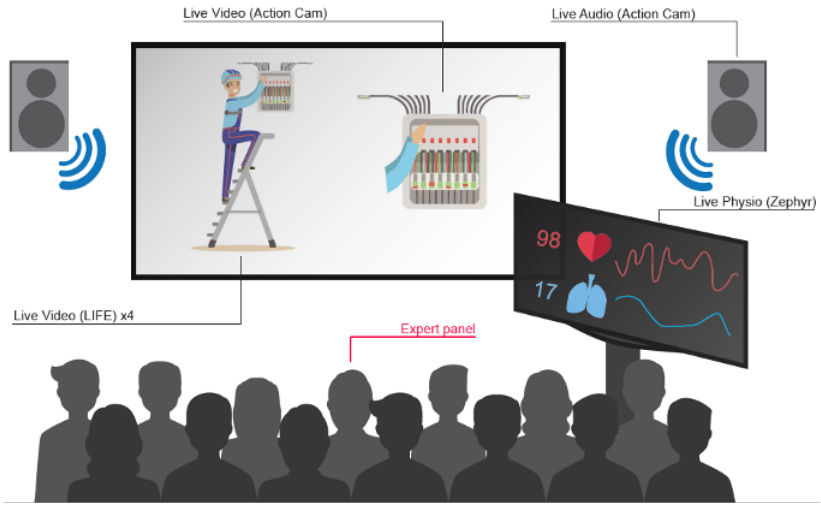
Figure 3. Perspective from the debriefing room.